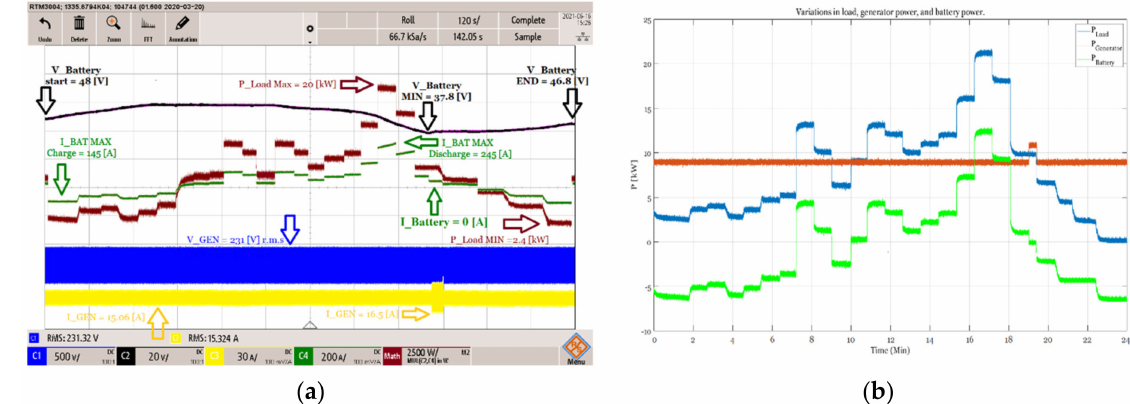
Figure 15. Experimental results based on standard sizing procedure: ( a ) system voltage currents and power on oscilloscope. ( b ) MATLAB processed power system balancing (blue–load, green–battery, and red–generator).